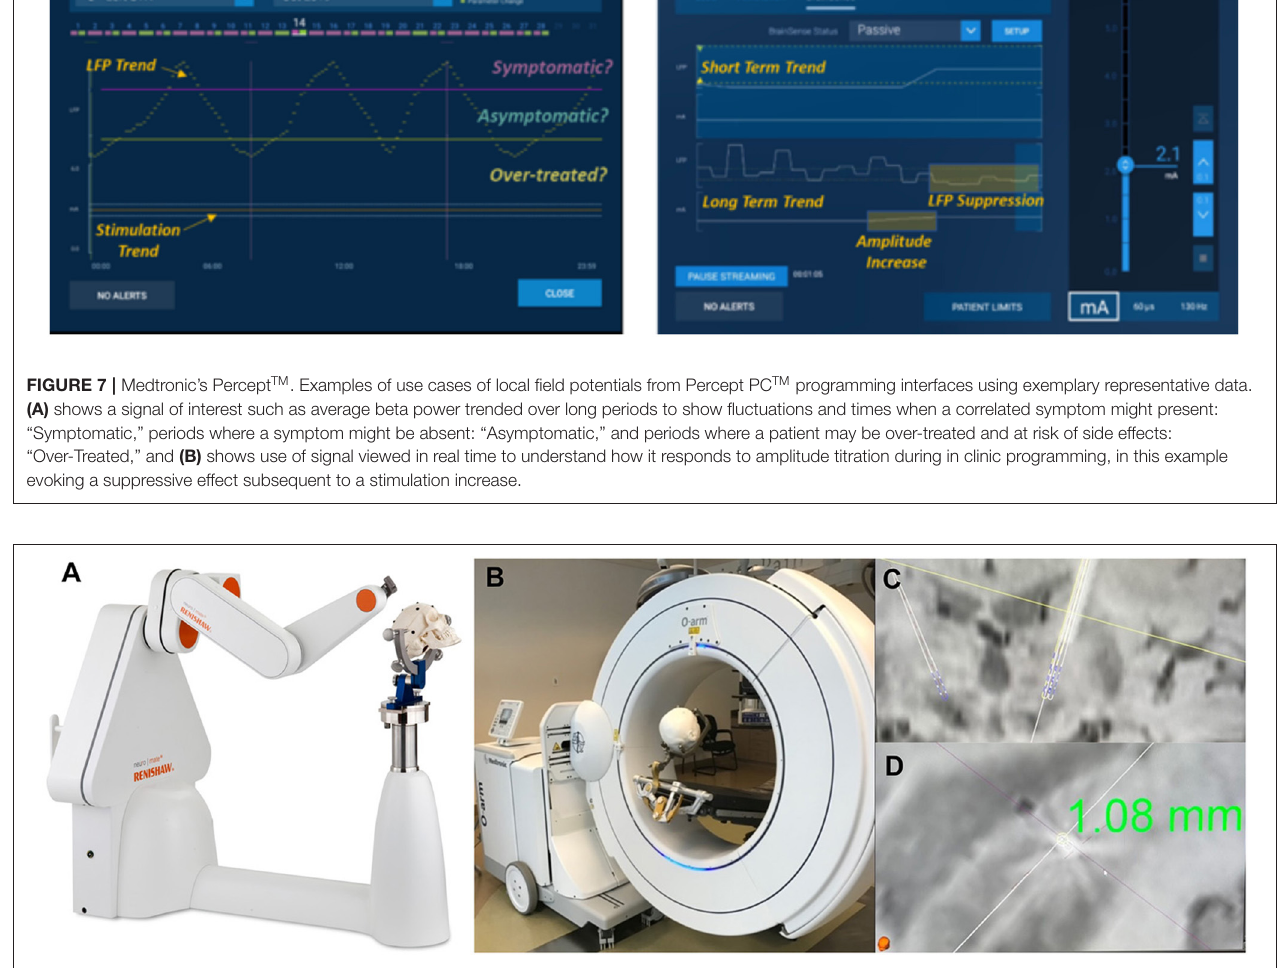
FIGURE 8 | Robotic Surgery assisted by Intraoperative Imaging. The utility of combining intraoperative robotic technology with intraoperative imaging allows for real time evaluation of accuracy of lead placement regarding the preoperative planned trajectory. This allows for adjustment of the cannula trajectory prior to MER recordings or lead placement. (A) Renishaw Neuromate robot. (B) Medtronic O-arm with mock set-up for acquiring intraoperative imaging. (C,D) Intraoperative O-arm image fused with preoperative SWI MRI showing a 1.08mm lateral deviation from the planned trajectory.